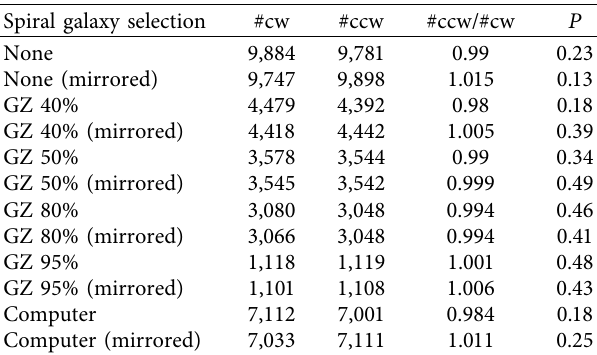
Table 6: Te distribution of galaxy spin directions in the hemi- sphere ( α < 120 o ∪ α > 330 o ) . Spiral galaxy